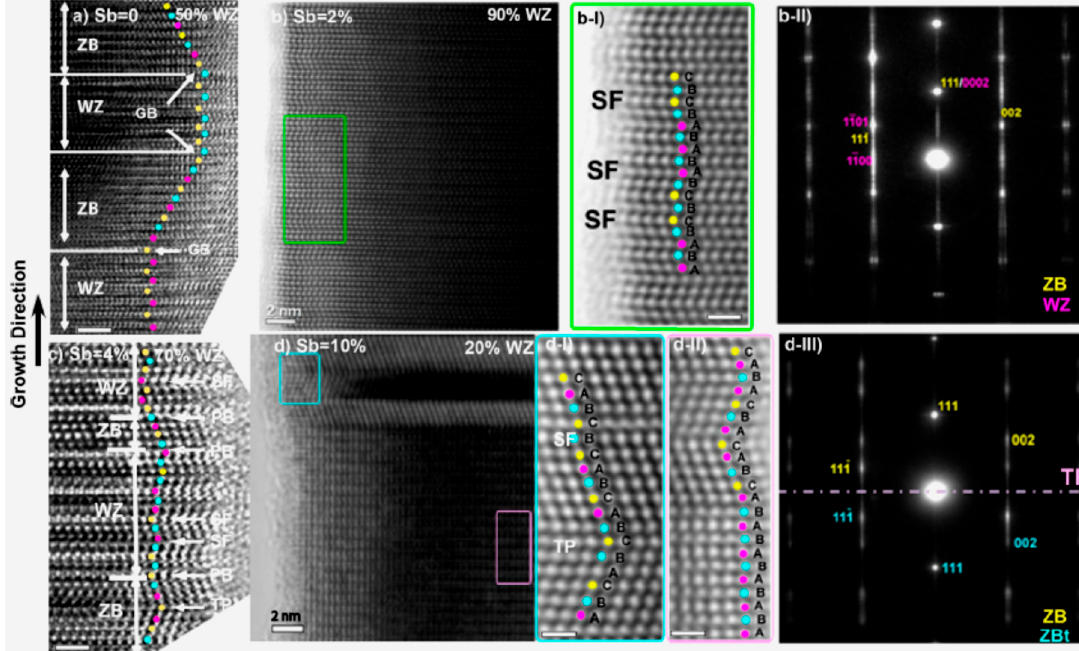
Figure 5. High-resolution TEM (HRTEM) images of InAs 1 − x Sb x NWs with Sb content of ( a ) 0, ( b ) 2, ( c ) 4, and ( d ) 10%. The InAs NWs (Sb content of 0%) have a ZB dominant structure with WZ fraction of 20%. The addition of Sb with the content of 2% and 4% resulted in WZ predominant phase, while the further increase of Sb content (10%) led to ZB predominant structure. Magnified HRTEM image of the highlighted region of sample ( b ) is shown in ( b-I ) with the corresponding fast Fourier transform (FFT) pattern showing in ( b-II ). Magnified HRTEM images of the highlighted regions of the sample ( d ) are shown in ( d-I and d-II ) with the corresponding FFT pattern showing in ( d-III ). These magnified images show the stacking in the structure, revealing ZB and WZ structures and SF and TP. The scale bar is 1 nm. Reproduced with permission from [53]; Copyright 2015, American Chemical Society.